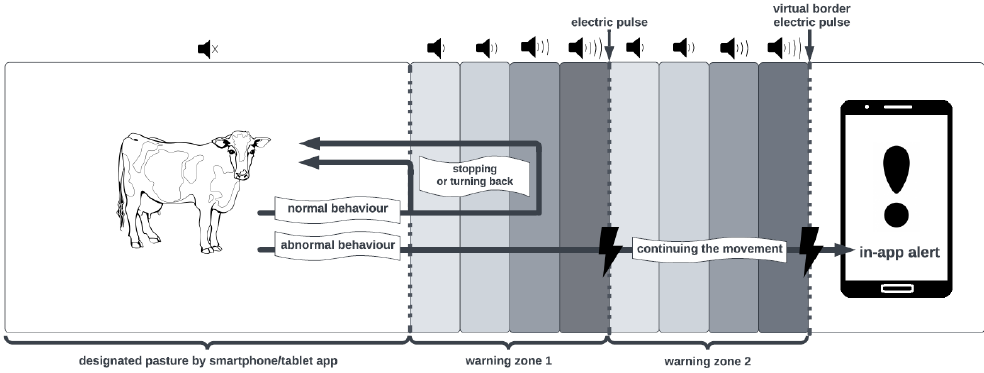
Figure 2. Possible response of grazing animals to virtual fencing.